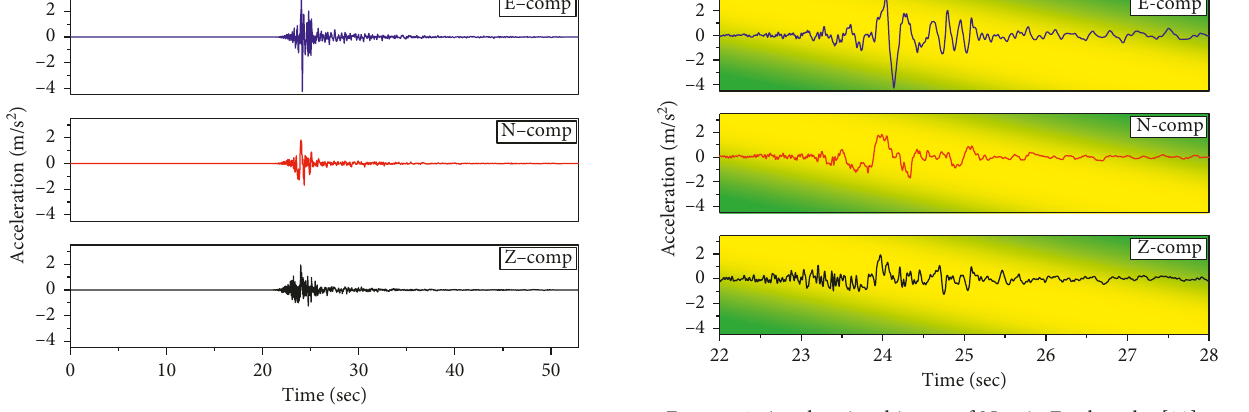
Figure 3: Acceleration history of Norcia Earthquake [20].